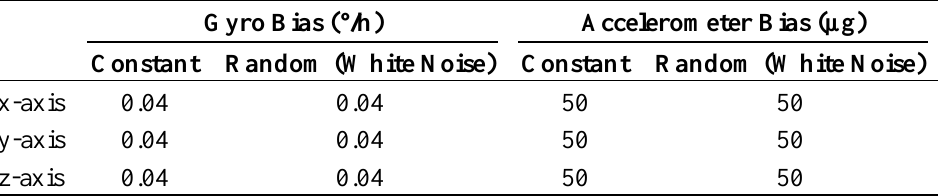
Table 3. Sensors errors